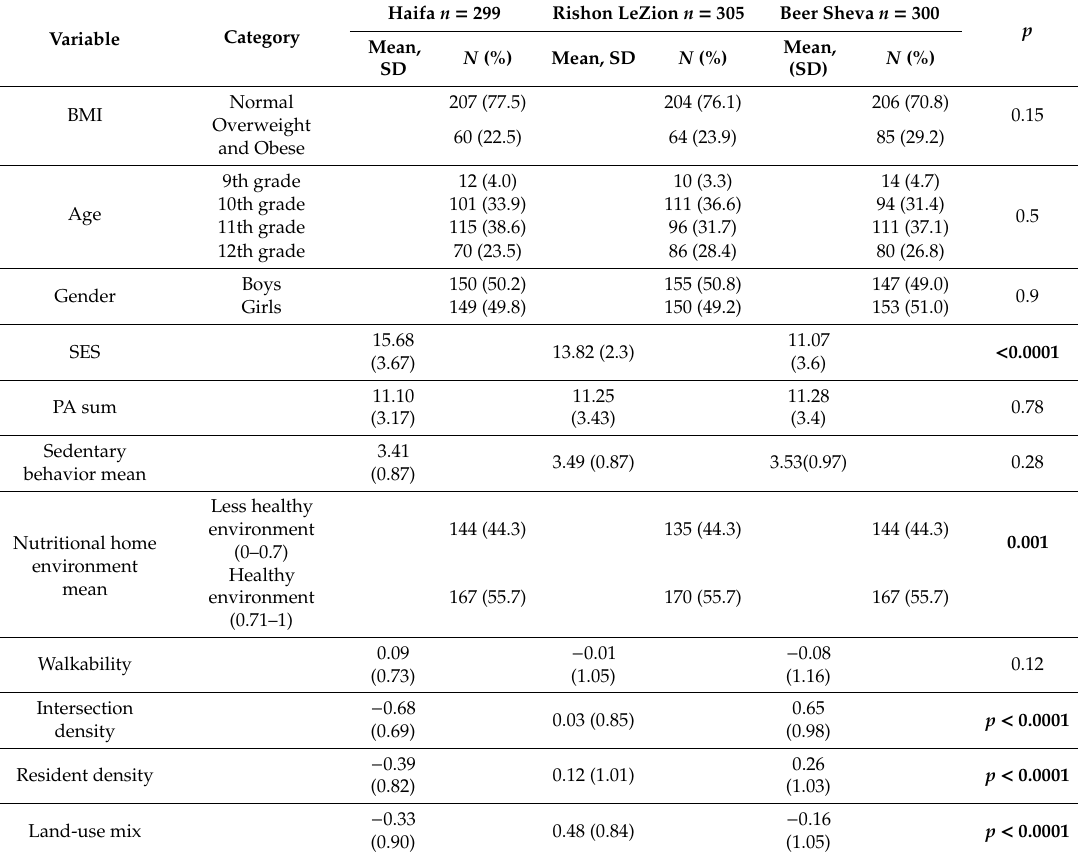
Table 1. Sample characteristics by city, mean, standard deviation for continues variables, and percent for categorical variables, p values for di ff erence between cities, n =